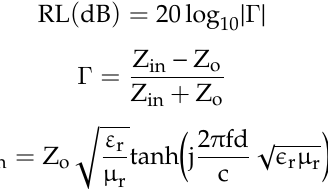
Figure 9. Frequency dependency of C (cid:2925) = μ (cid:2969)(cid:2969) (μ (cid:2969) ) (cid:2879)(cid:2870) f (cid:2879)(cid:2869) values for all samples. The magnitude of EM wave absorption represented by reflection loss (RL) of all samples were calculated from Equations (16)–(18) below based on the transmission line theory [25], using the FEM